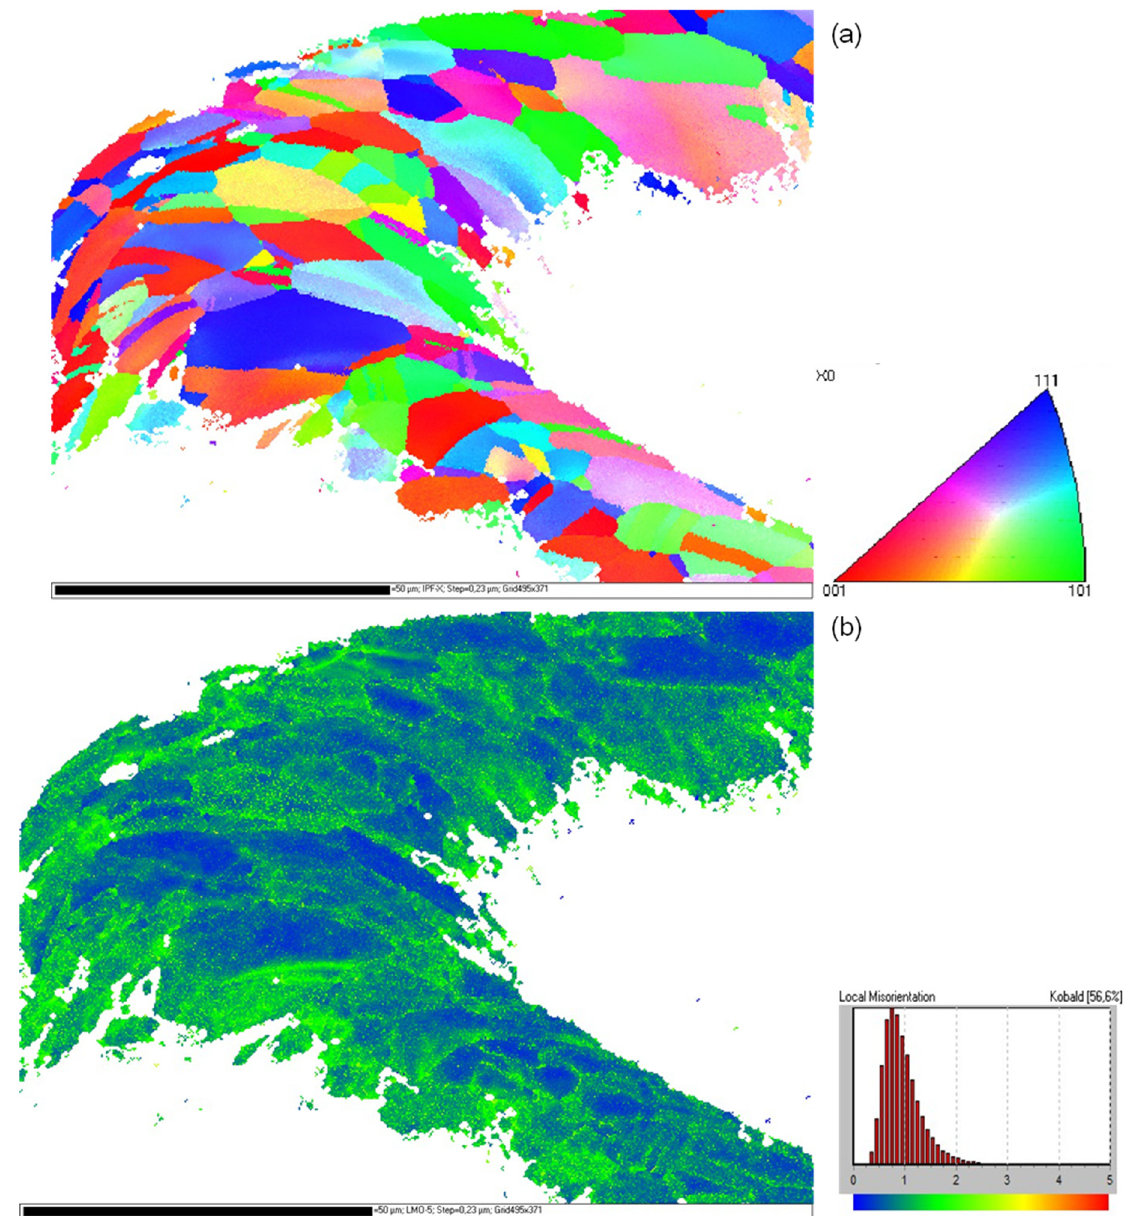
Figure 3. ( a ) Inverse pole figure orientation mapping of an F-562 stent bow (Driver) after dilation; ( b ) Kernel misorientation mapping of this stent bow. The colorings of the mappings are according to the given